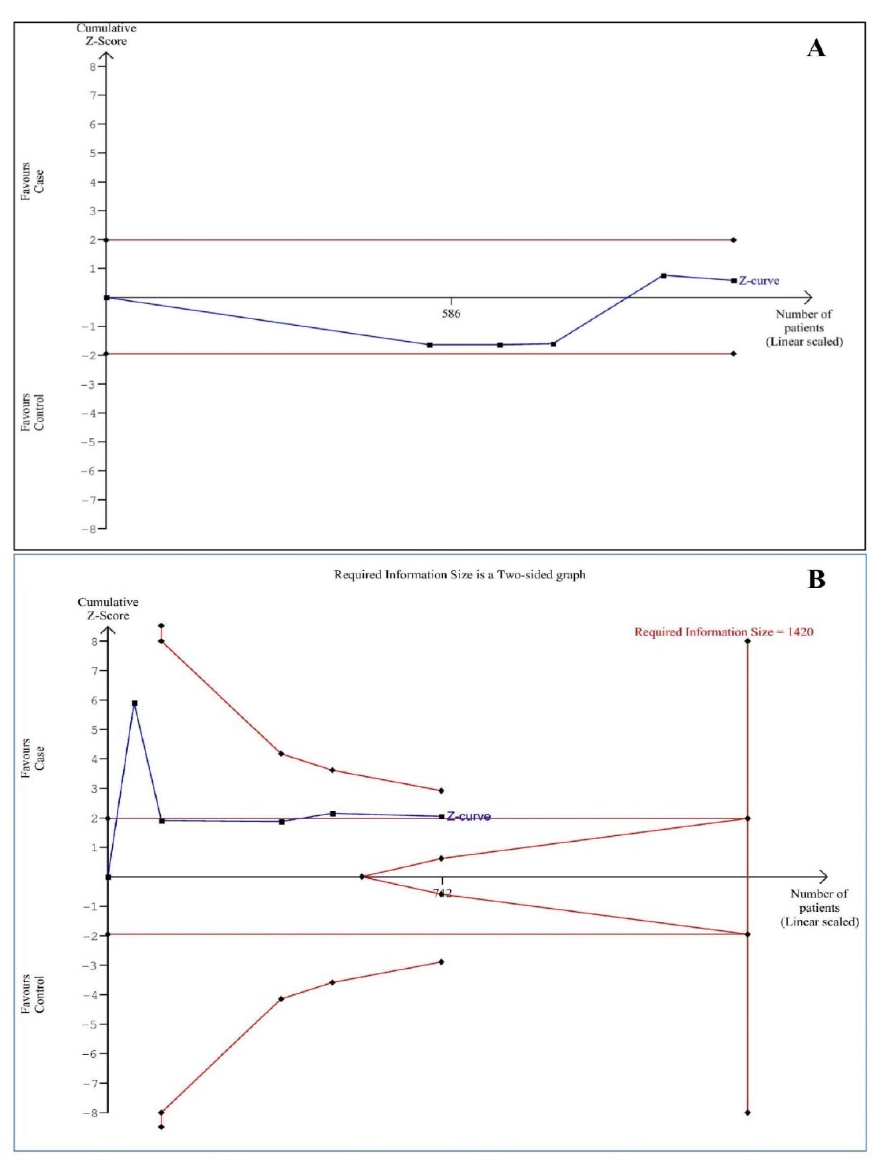
Figure 5. Trial sequential analysis of studies assessing salivary iron ( A ) and serum ferritin ( B ) levels.